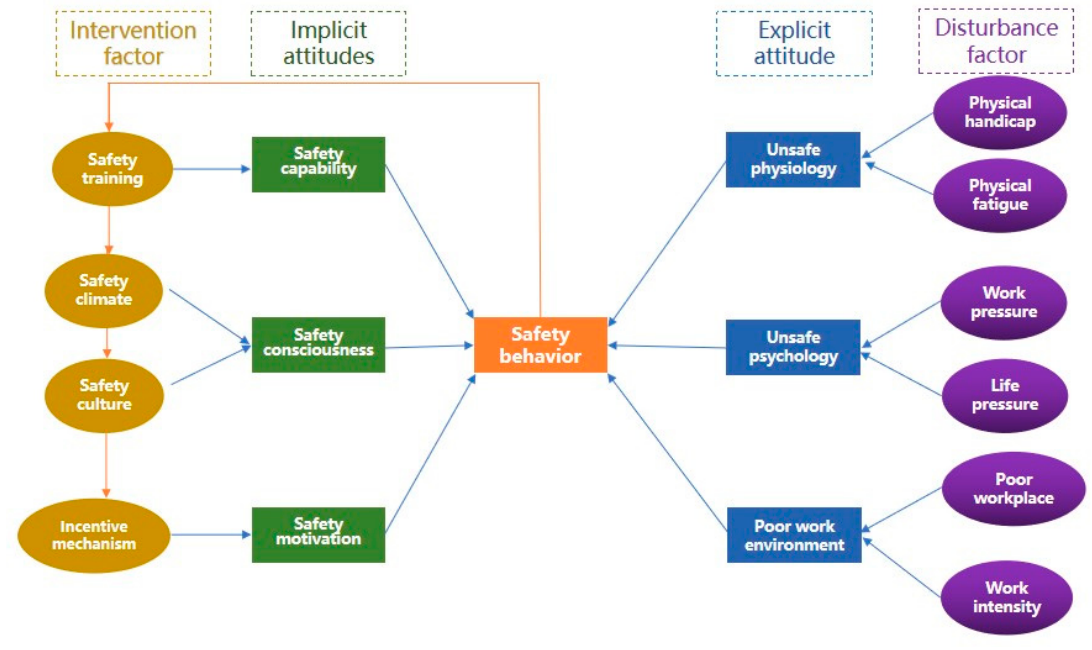
Figure 2. A dual-attitude theoretical model based on construction workers’ unsafe behavior.